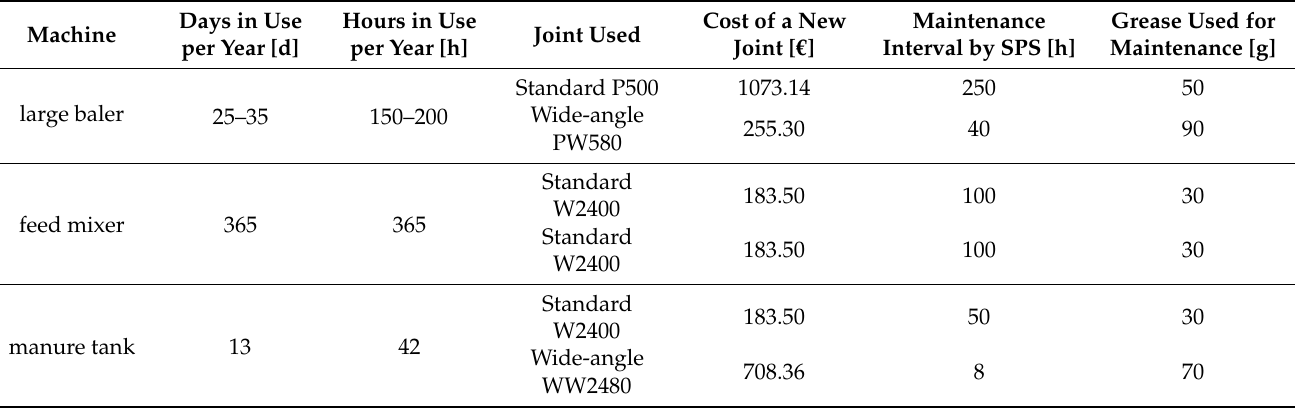
Table 3. Assumptions for the three machines used in the practical simulation for cost